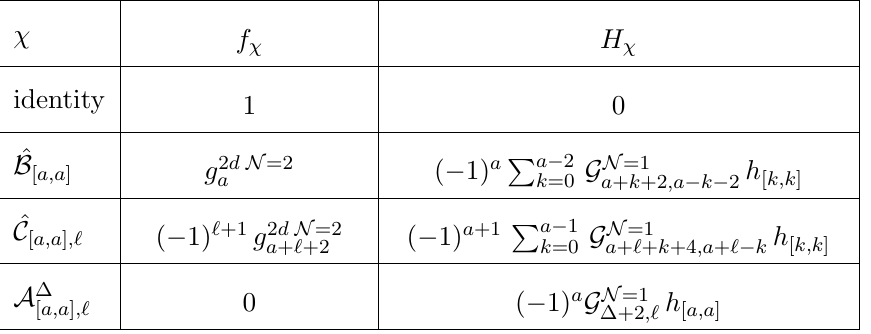
Table 2 . Superconformal blocks contributing to (3.21) in the parametrization (3.17). These ex- pressions are consistent with the decompositions of superblocks at unitarity bounds, see